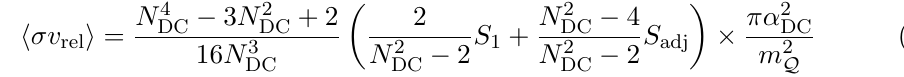
Figure 11 . Model with G DC = SU(3) and a dark quark neutral under G SM . averaged cross sections for annihilation and for bound states formation, assuming m and (cid:11) = 0 : 1 ((cid:3) DC 30 GeV). Right: region where dark baryons reproduce the DM cosmological DC (cid:25) abundance. A recombination fraction } = 0 : 4 is B